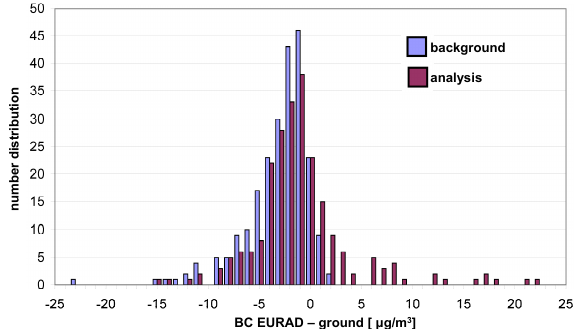
Fig. 2. Number distribution of differences BC x b − ground and BC x a − ground for 231 coincidences in the United Kingdom within July to November 2003 for both the background (blue) and the anal- ysis (purple)